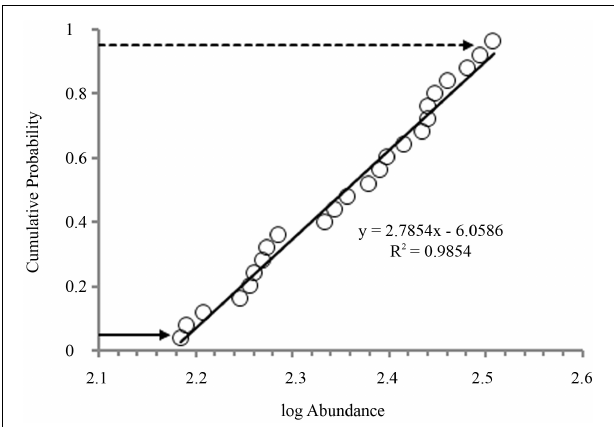
FIGURE 3 | Cumulative probabilistic distributions of all the sample values indicating 5 and 95%